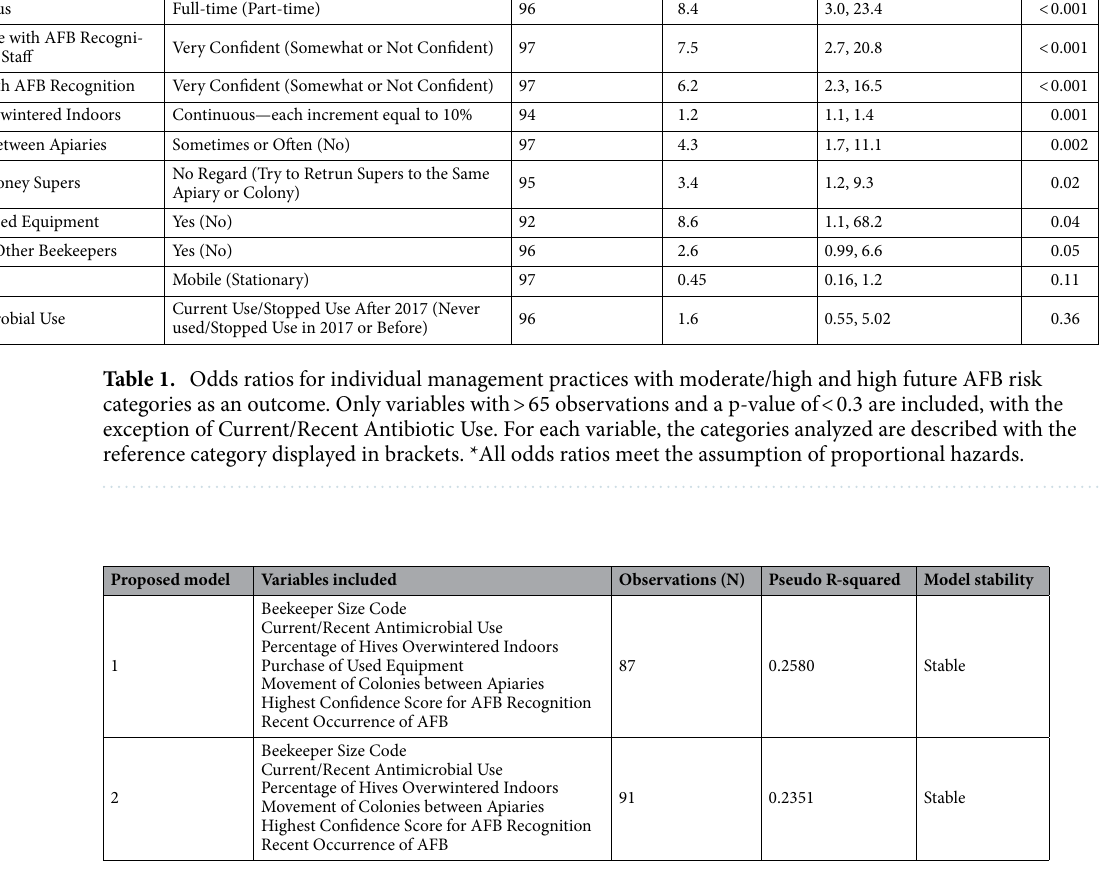
Table 2. Proposed ordered logistic regression models for prediction of a beekeeper’s risk of AFB. Combined medium and high risk categories were compared to the low risk category (less than two spores per gram of honey), and the high risk category (greater than or equal to 100 spores per gram of honey) was compared to combined low and medium risk. Models were differentiated from one another by pseudo R-squared values, number of observations, and overall model